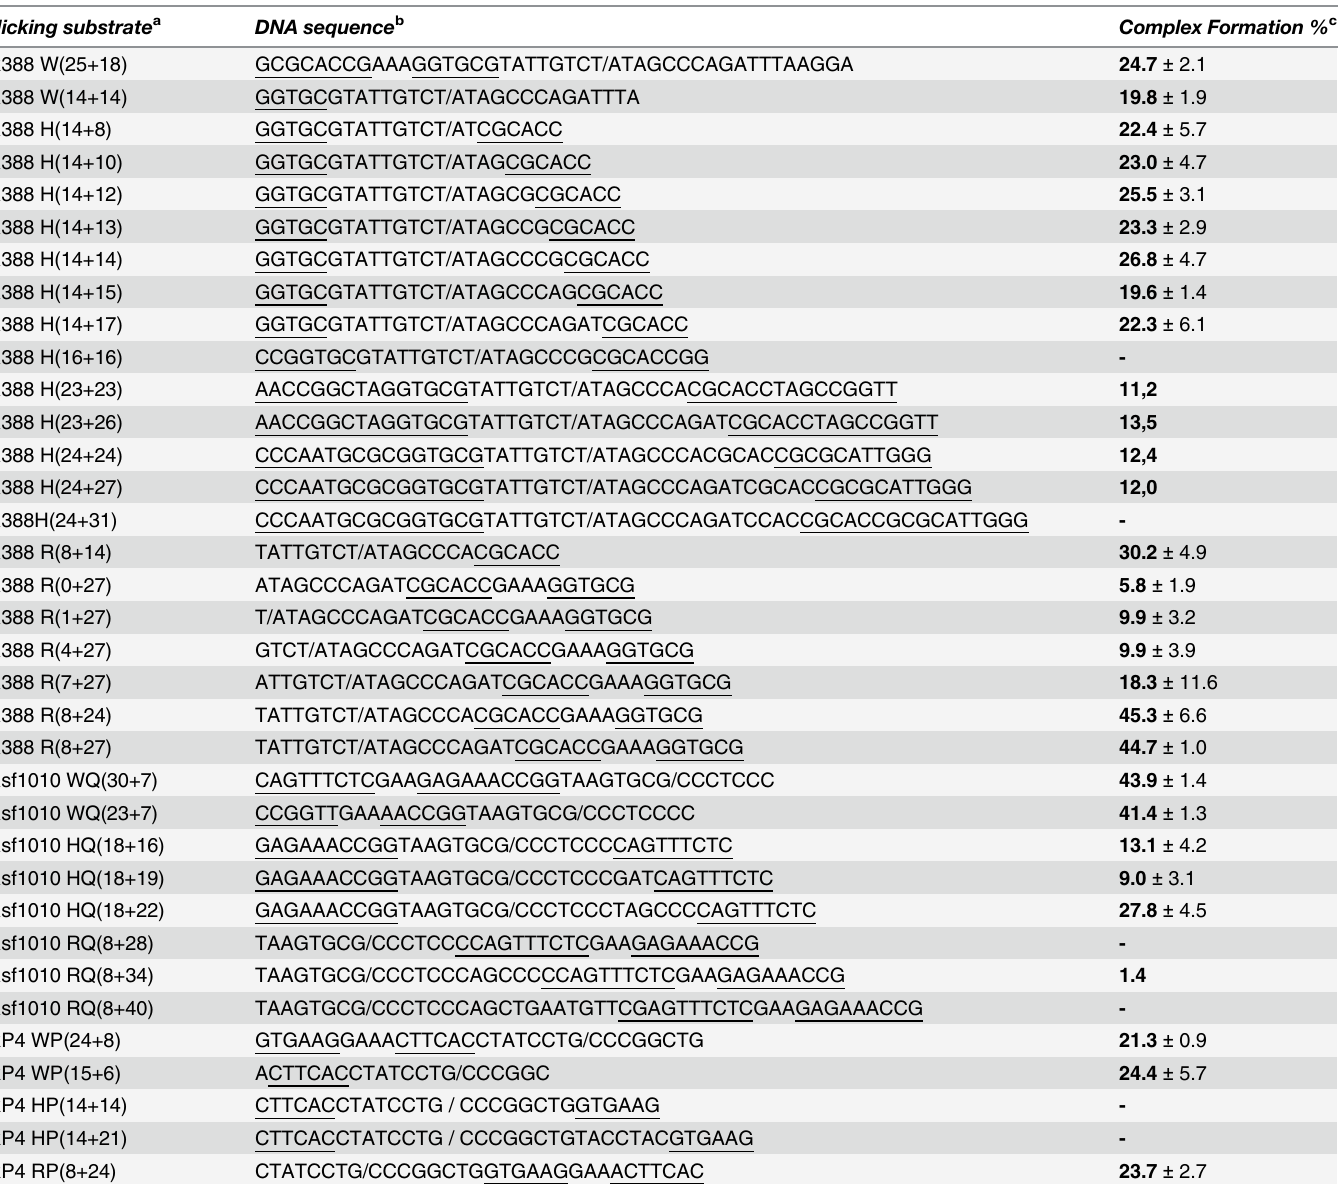
Table 1. Cleavage activity of TrwC R on different